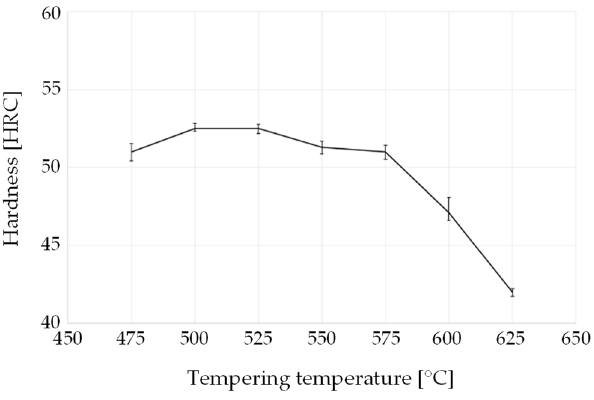
Figure 5. Tempering chart of L-PBF-fabricated hot-work tool steel AISI H10.